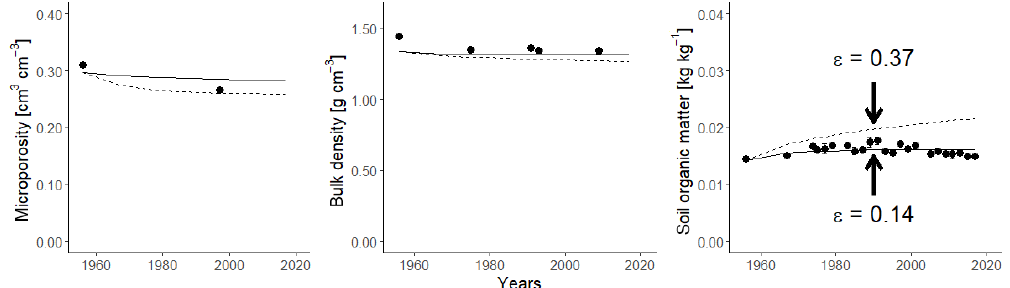
Figure 11. Observed (symbols; bars show standard deviations) and simulated (lines) microporosity (cm 3 cm − 3 ), bulk density (gcm − 3 ) and soil organic carbon concentration (kgkg − 1 ) for the green manure treatment for two different values of the OM retention coefficient, ε